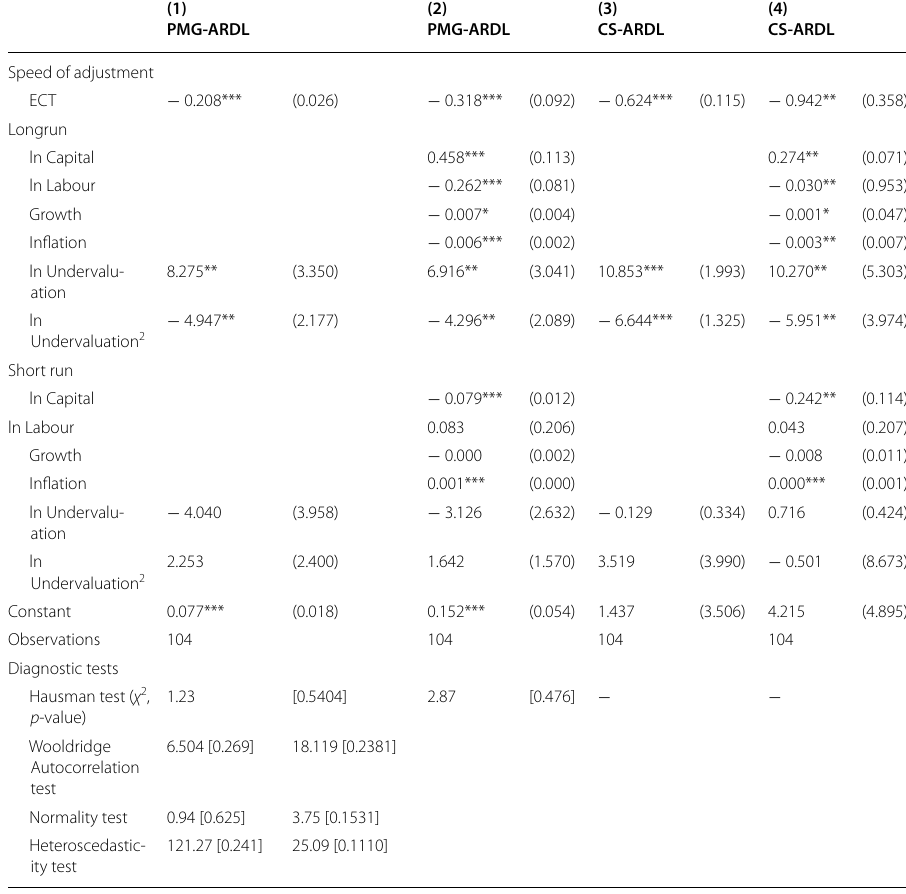
Table 8 Nonlinearities of undervaluation and service sector performance. Source: Authors’